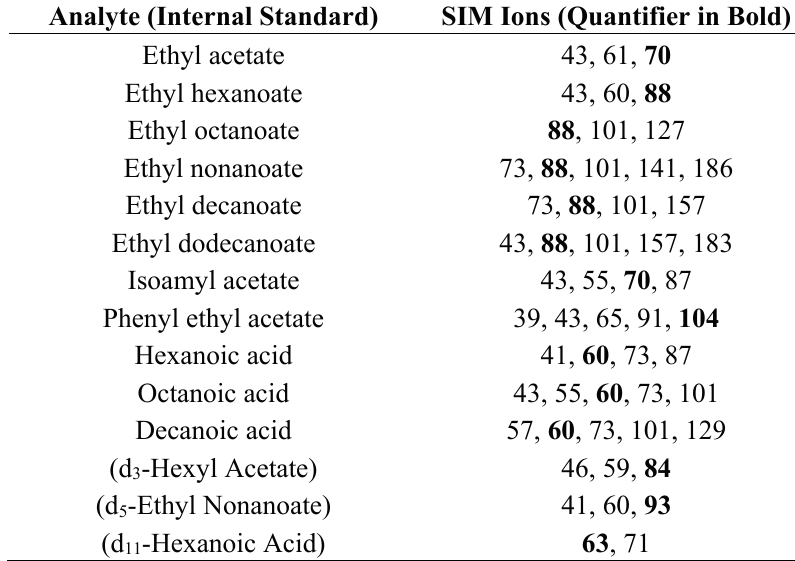
Table 1. Qualifier and quantifier ions used for GC-MS analysis of fermentation volatiles in SIM